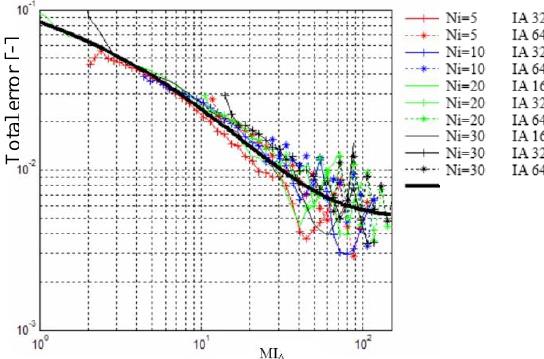
Fig. 6. Influence of seeding density and interrogation area size for MI∆